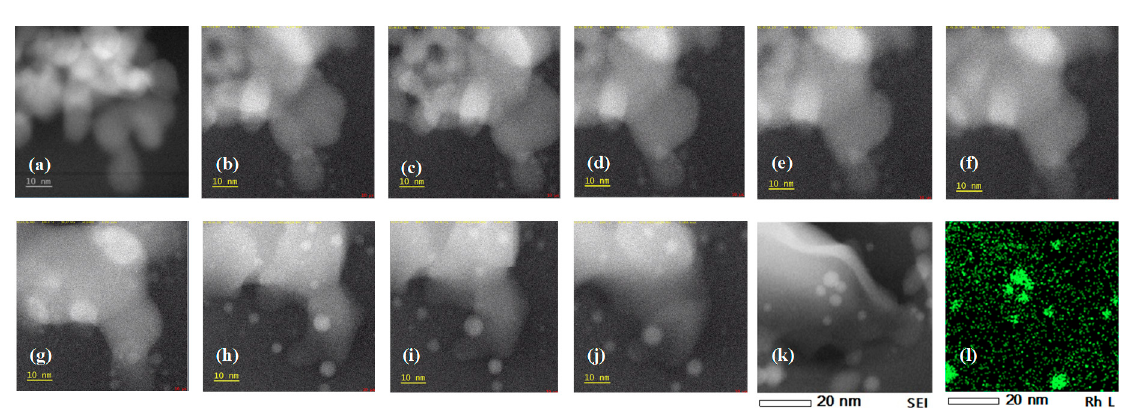
Figure 8. In situ TEM images of Rh/ZrO 2 at ( a ) 300 °C, ( b ) 918.1 °C, ( c ) 932.5 °C, ( d ) 941 °C, ( e ) 944.2 °C, ( f ) 948.8 °C, ( g ) 950 °C, ( h ) 968.7 °C, ( i ) 983.8 °C, and ( j ) 1000 °C. ( k ) TEM data at 300 °C after cooling from 1000 °C. ( l ) EDS measurement result after (j) at the same observation point. The atmosphere was N 2 for ( a )–( g ) and changed to 1% O 2 /N 2 in ( h )–( j ).